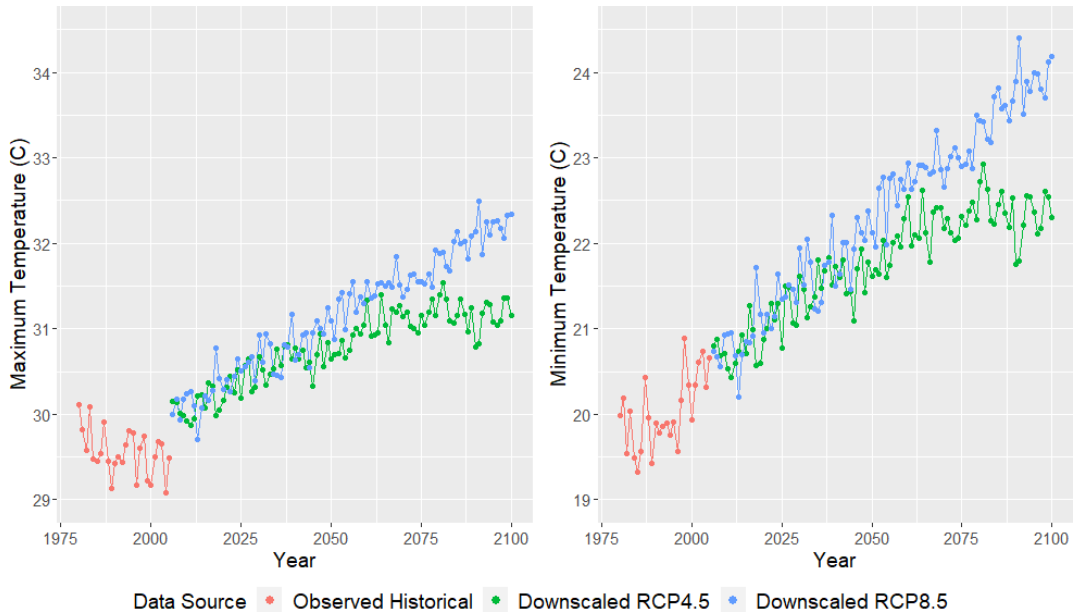
Figure 12. CanESM2 mean daily maximum (left panel) and minimum (right panel) temperature ( ◦ C) as a function of year. Observed historical GHCN data from 1980–2005 are plotted in red, while downscaled RCP4.5 and RCP8.5 temperatures from 2006–2100 are plotted in green and blue, respectively. This figure was created using Wickham